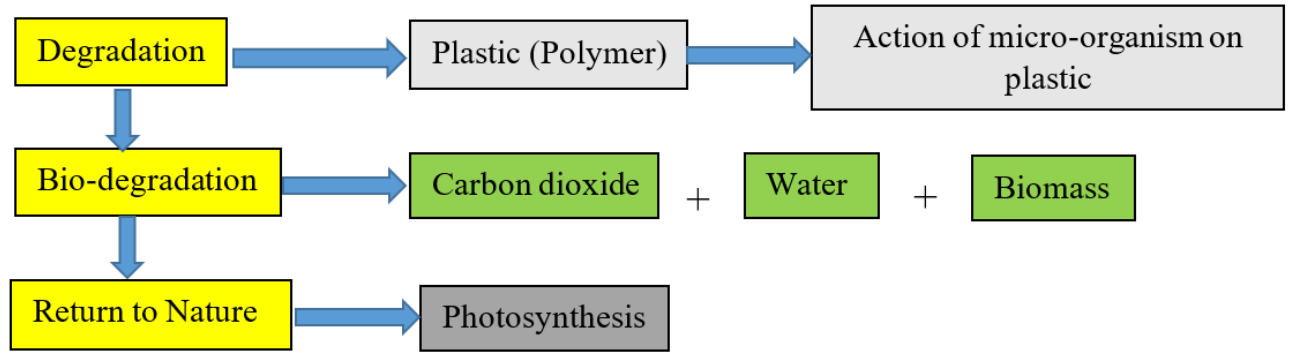
Figure 1. The process of biodegradation.